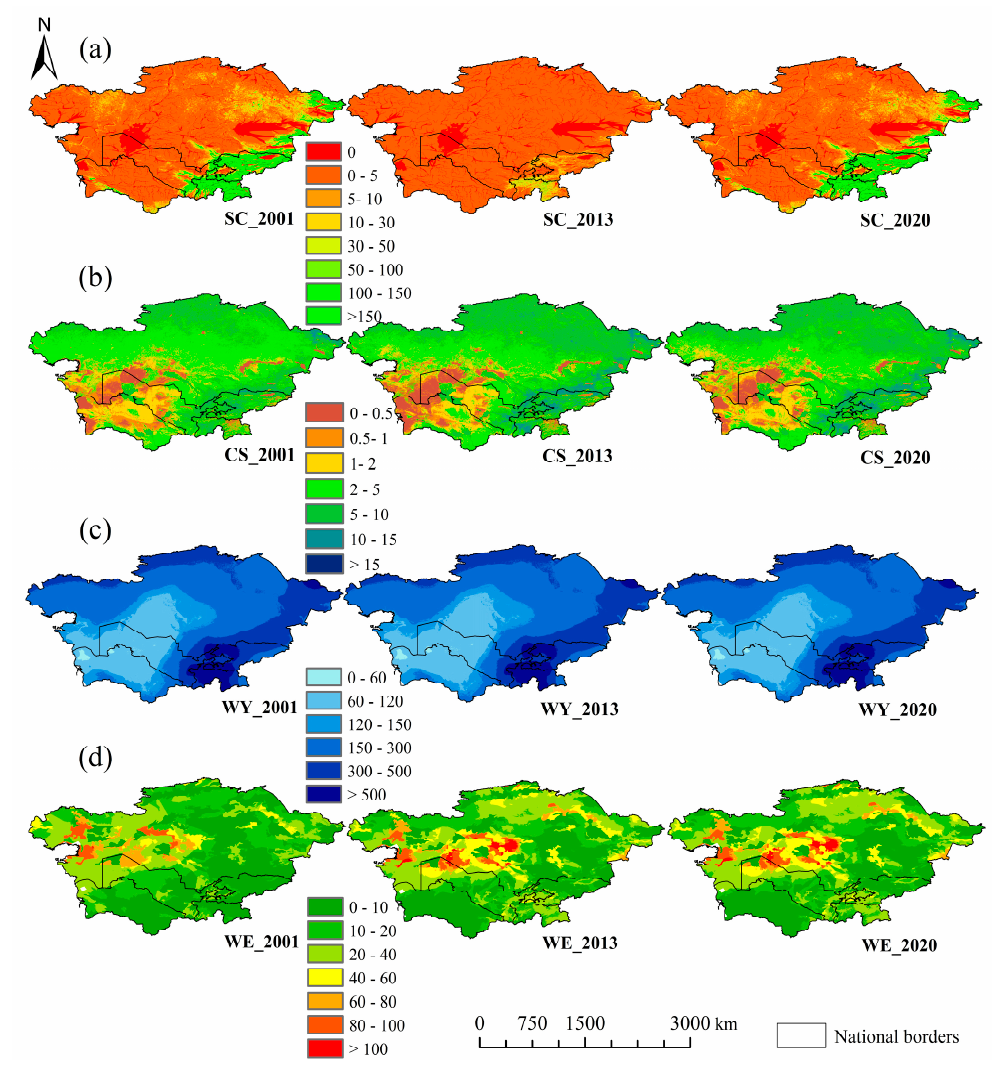
Figure 6. Spatial distribution of ESs in the CANs in 2001, 2013, and 2020. ( a ) SC; ( b ) CS; ( c ) WY; ( d ) WE. (SC, CS, WY, and WE refer to soil conservation, carbon sequestration, water yield, and wind erosion, respectively. The unit of SC and CS is t·hm − 2 , of WE is kg·m –2 , and of WY is mm). Figure 7. Spatial change in the ESs before BRI (2001 − 2013), after BRI (2013 − 2020) and 2001 − 2020. ( a ) SC change; ( b ) CS change; ( c ) WY change; ( d ) WE change. (SC, CS, WY, and WE refer to soil conservation, carbon sequestration, water yield, and wind erosion, respectively. The unit of SC and CS is t·hm − 2 , of WE is kg·m –2 , and of WY is mm).